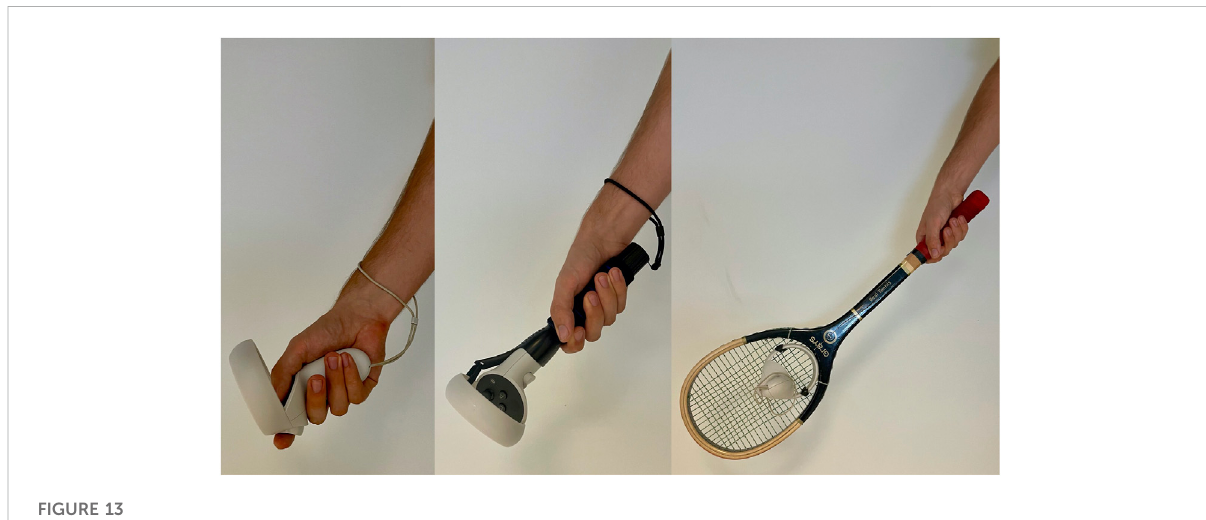
FIGURE 13 Different modes of virtual racket